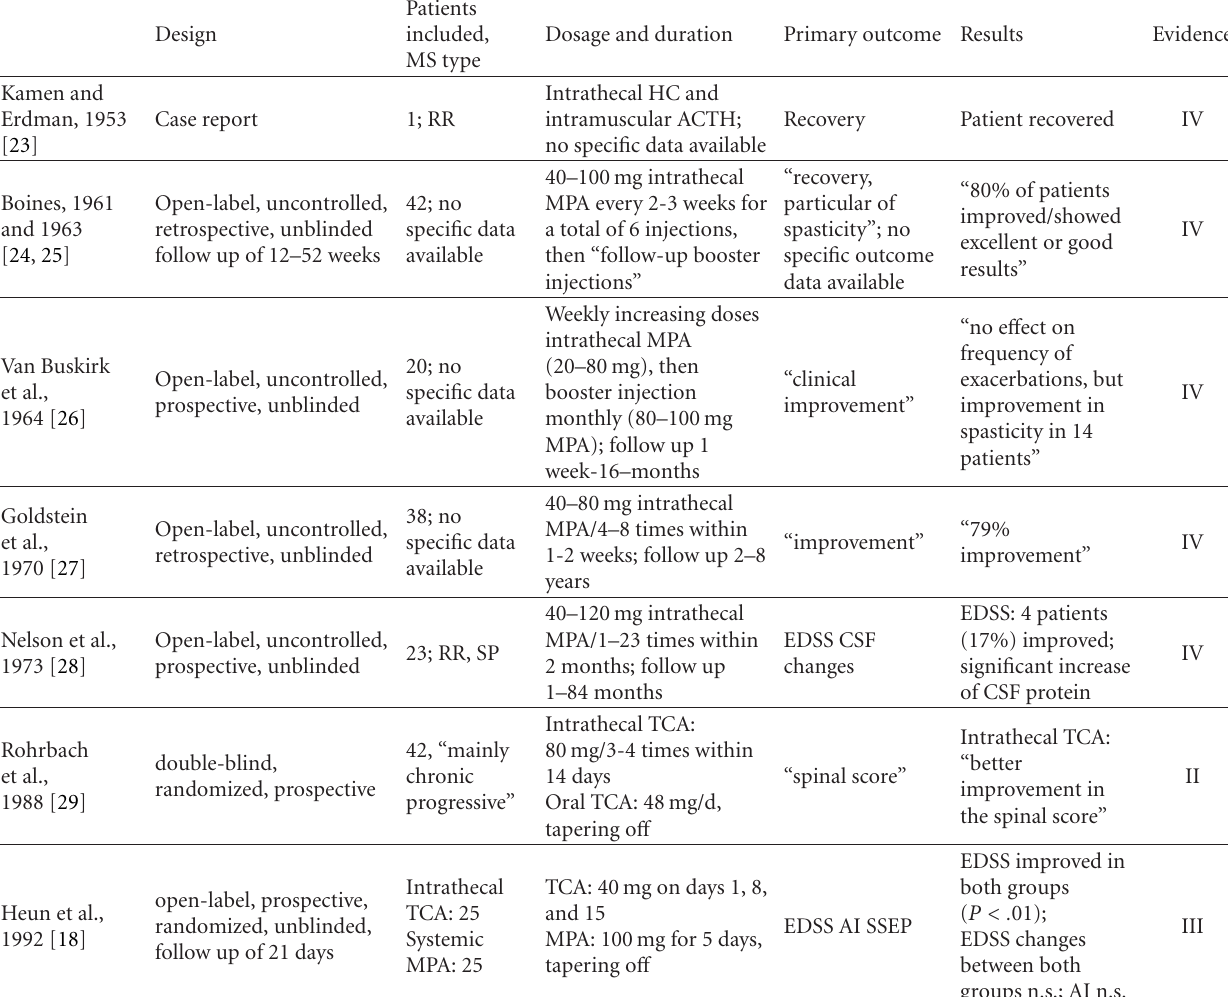
Table 1: Representative intrathecal steroid trials 1953–1992 [21,